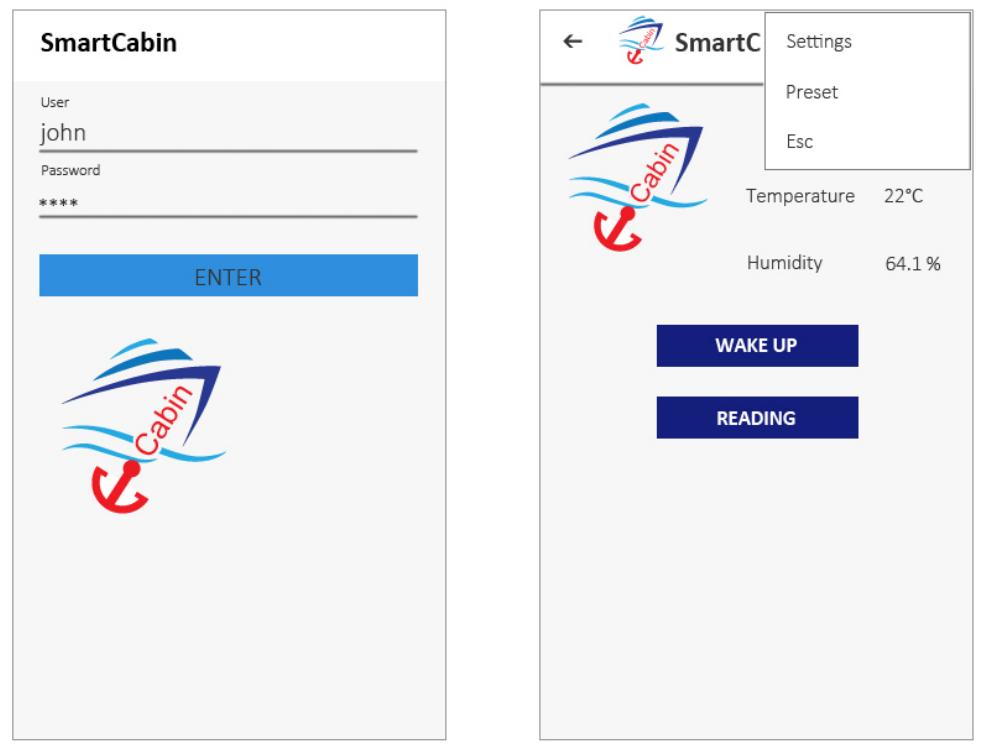
Figure 11. Log in screen-shoot (on the left ) and Home Page screen-shoot (on the right ) of the Smart Cabin